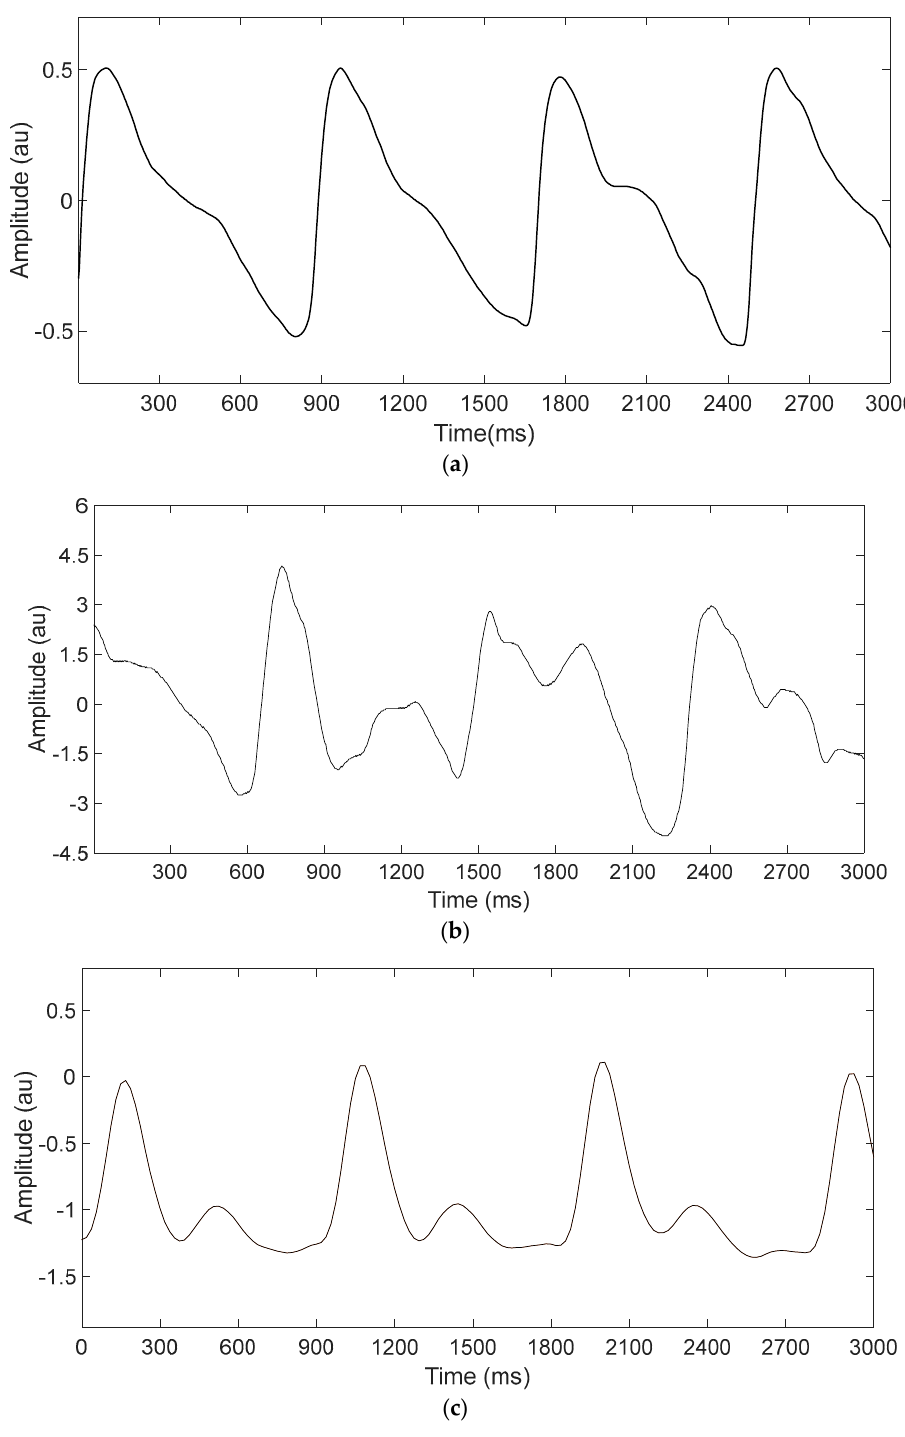
Figure 7. Representative PPG signal examples measured in dry and underwater environments. ( a ) PPG signals measured in dry environment and ( b ) in underwater environment using Samsung Galaxy Note8, and ( c ) a reference PPG signal measured using NeXus-10